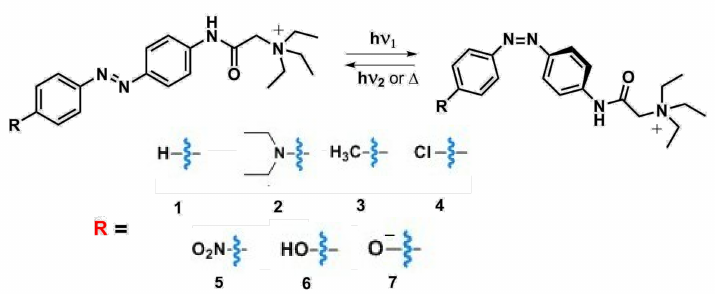
Figure 1. The structure of azobenzene/tetraethyl ammonium photochromic ligands considered in the current